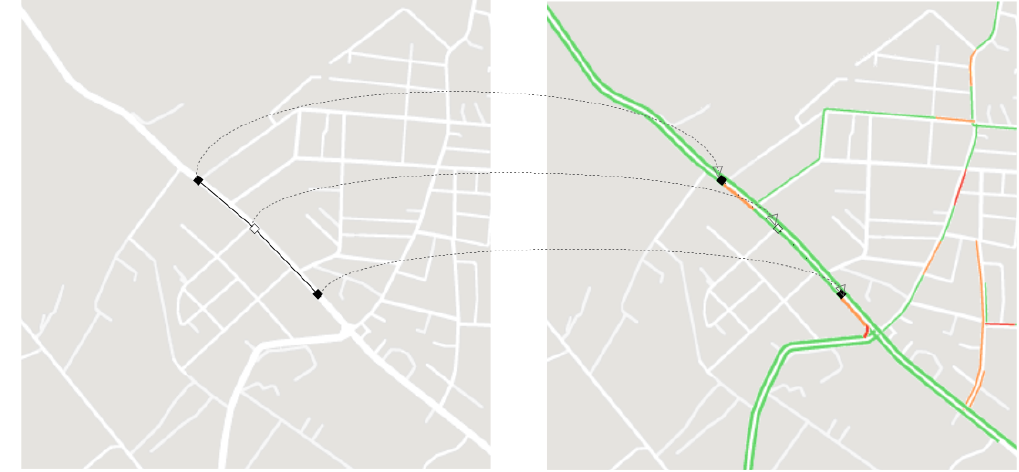
Figure 1. Extracting travel times from a